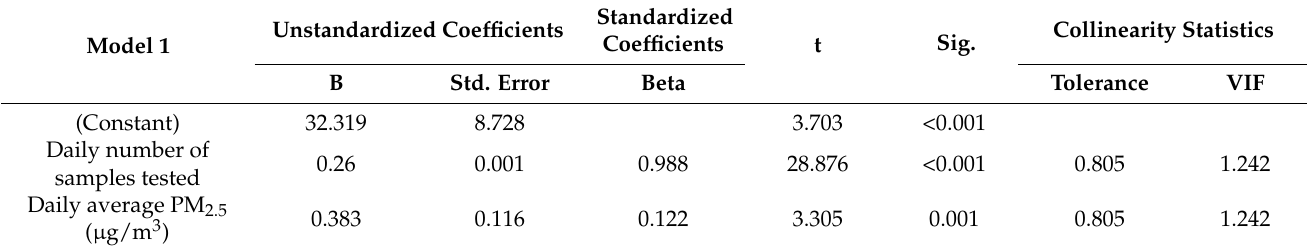
Table 6. Multiple regression analysis for daily COVID-19 incidence during the pre-lockdown period (24 February 2020–21 March 2020), considering a two-week lag in COVID-19 test results.